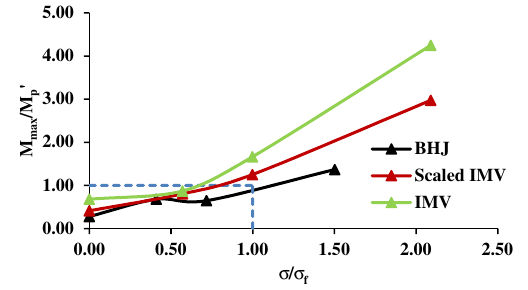
Fig. 21 Bending-buckling interaction graph of 0.5 m diameter pile in RCD soil due to the BHJ, scaled IMV and IMV motions